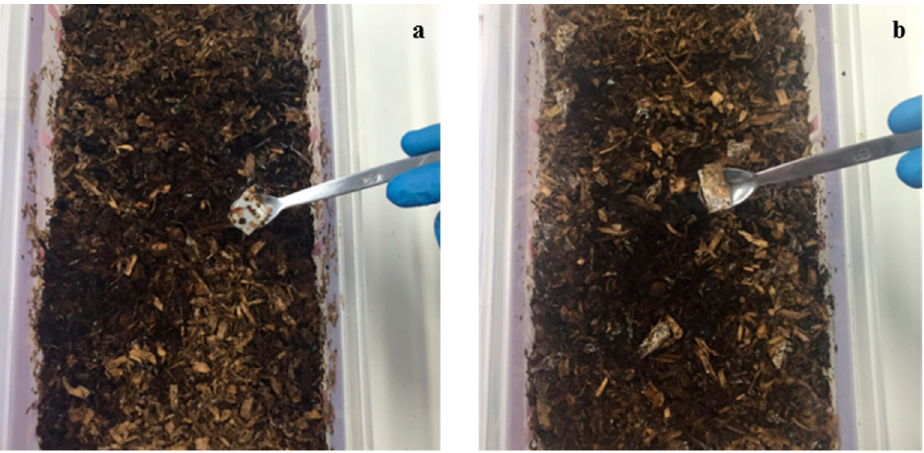
Figure 7. Photographic documentation of ( a ) PLA and ( b ) BIO E946 pieces after one week of disintegration test at 58 °C.